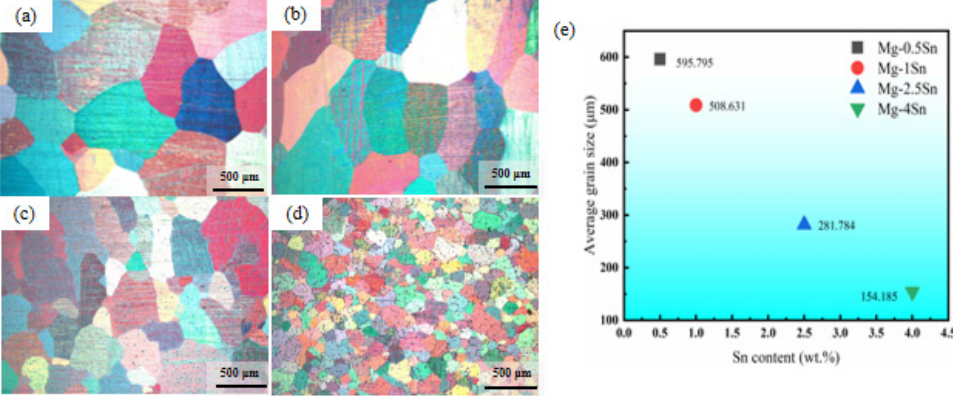
Figure 1. Optical microscopy metallographs of as-cast: ( a ) Mg-0.5Sn, ( b ) Mg-1Sn, ( c ) Mg-2.5Sn, ( d ) Mg-4Sn and ( e ) statistic of average grain size.